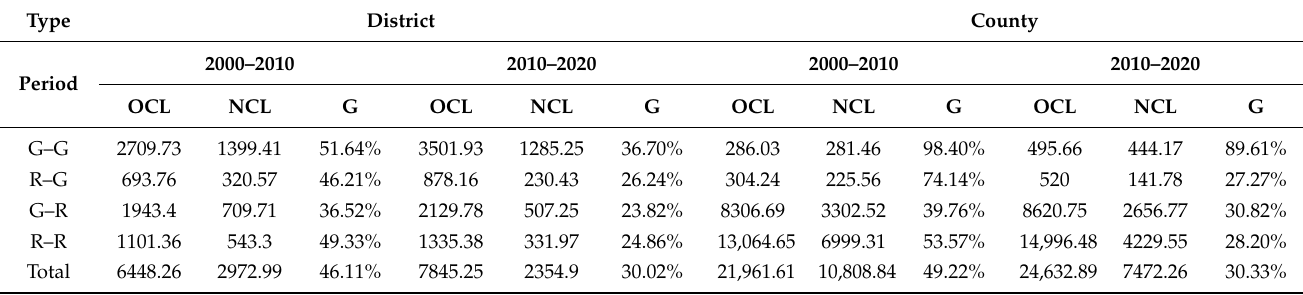
Table 1. Growth rate of new construction land in various research units, 2000–2010 and 2010–2020.